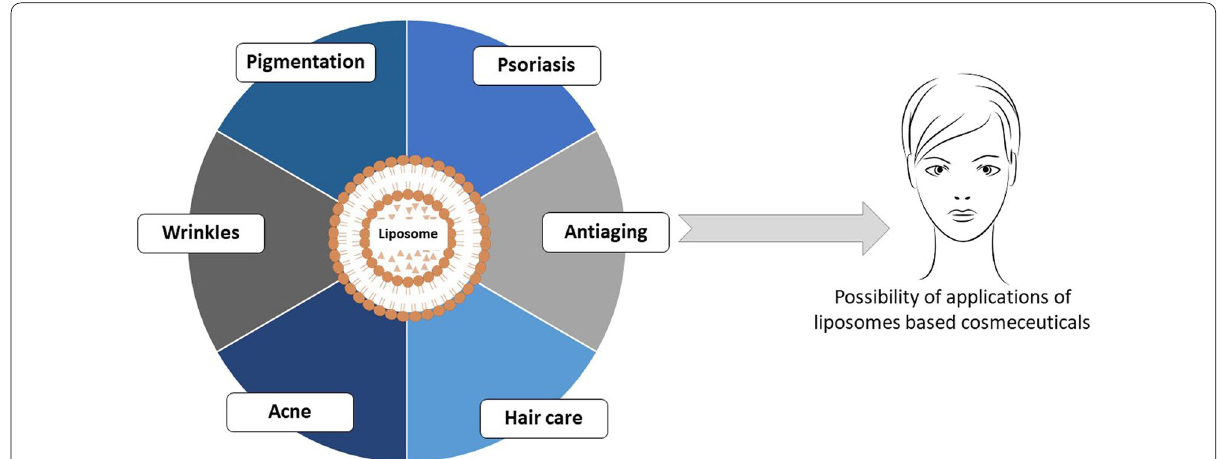
Fig. 3 Cosmeceutical applications of liposome-based